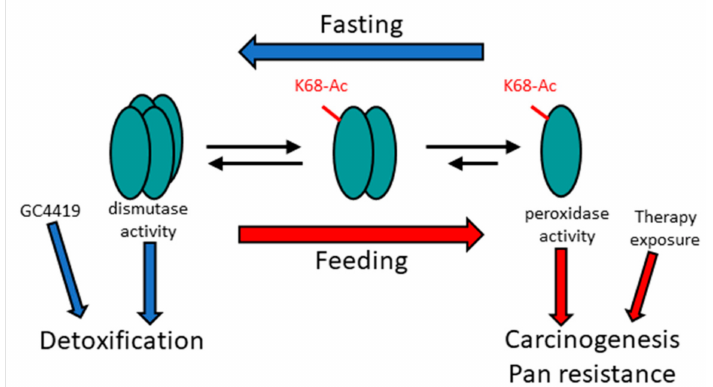
Figure 1. Proposed mechanism of MnSOD detoxification and peroxidase roles. The tetrameric detoxification complex plays a role in a fasting physiology (blue arrows), whereas increased monomeric MnSOD, and its peroxidase activity, may be required for mitochondrial reprogram- ming to generate energy in a feeding state (red arrows). Other genetic and/or other types of cell stress may also create an oncogenic phenotype, which reprograms the mitochondria by increasing